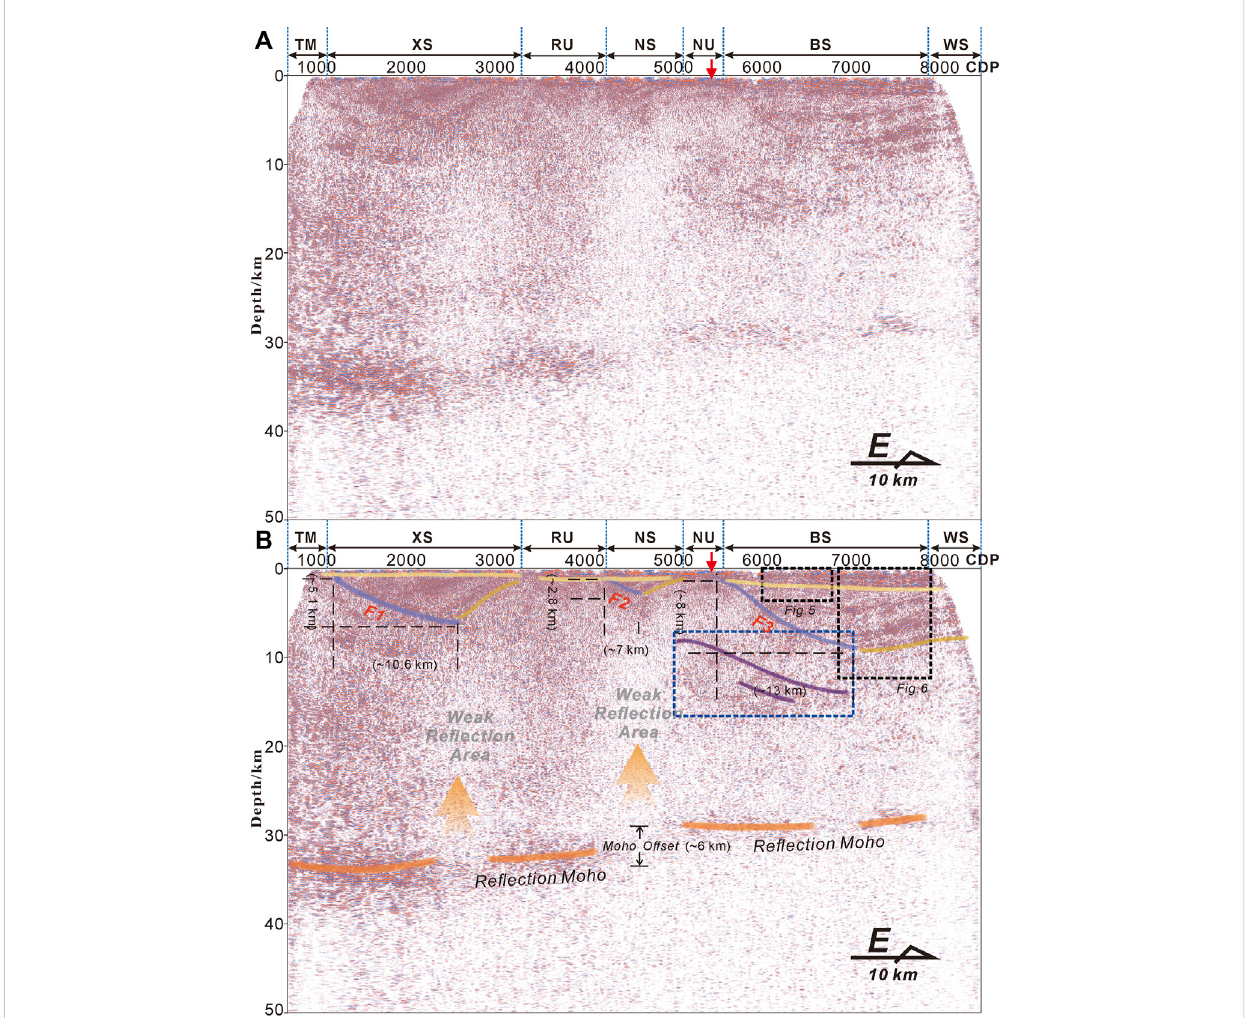
FIGURE 7 (A) PSDM pro fi le (B) Key elements of the interpretation show the main features of the PSDM pro fi le. The horizontal direction is CRP, and the reference datum is 50 m above sea